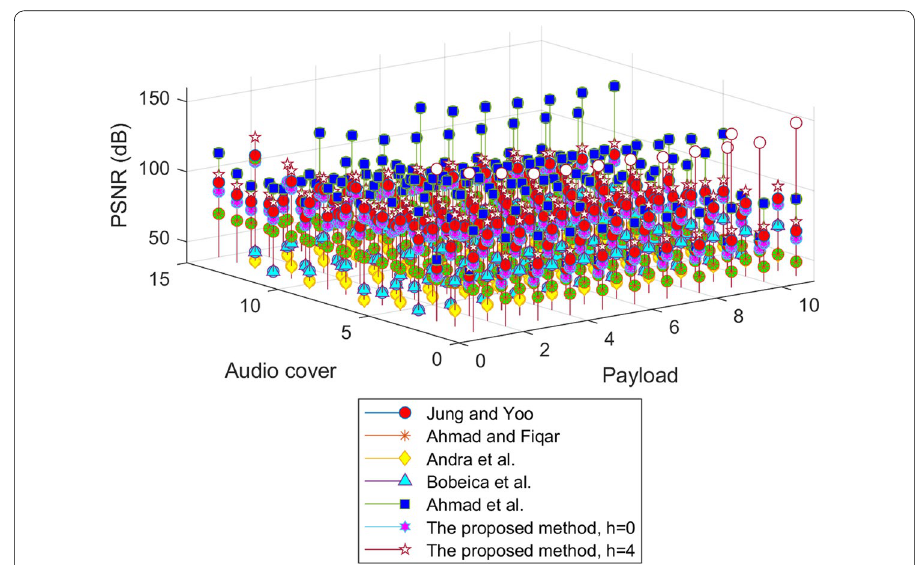
Fig. 11 The quality of the stego file generated by Jung and Yoo [29], Ahmad and Fiqar [30], Andra et al. [32], Bobeica et al. [33], Ahmad et al. [31], and the proposed technique with e = 3 , m = 1 , h = 0 and h =